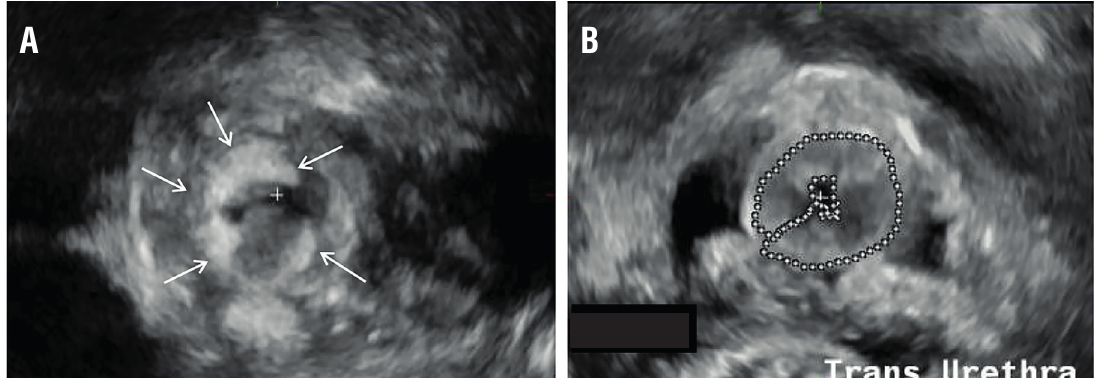
Figure 1 - (+)=Urethral lumen; 3DUS=Three-dimensional ultrasound. 3DUS reveals asymmetric MPQ configuration (A) compared to a symmetrical “horseshoe configuration” (B). MPQ is indicated by either arrows (A) or as outlined